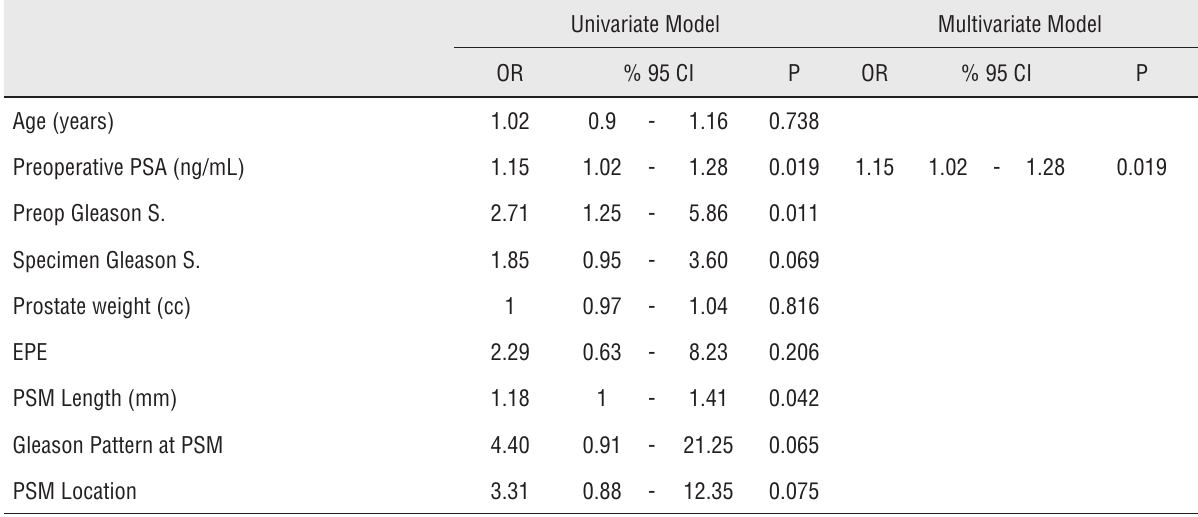
Table 3 - Parameters predicting biochemical